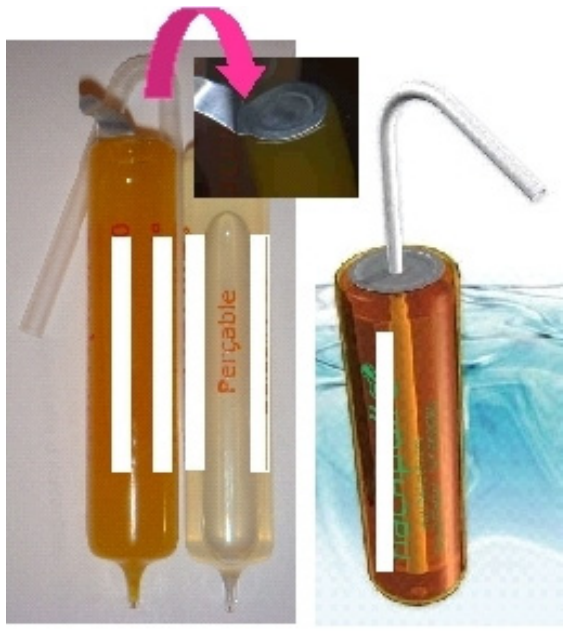
Figure 8. Glass vial and straw